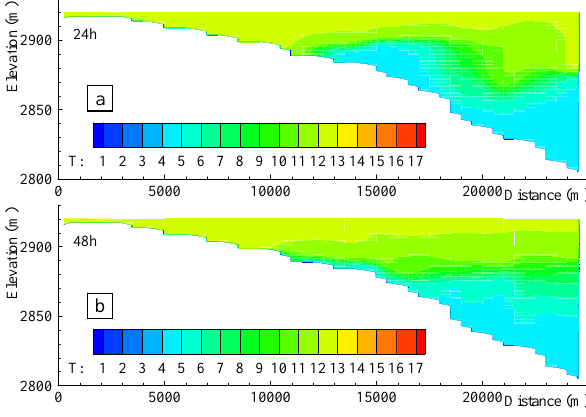
Fig. 6. Velocity vectors and streamlines in Bala Reservoir ( (a) Case 1 and Case 2; (b) Case 3).